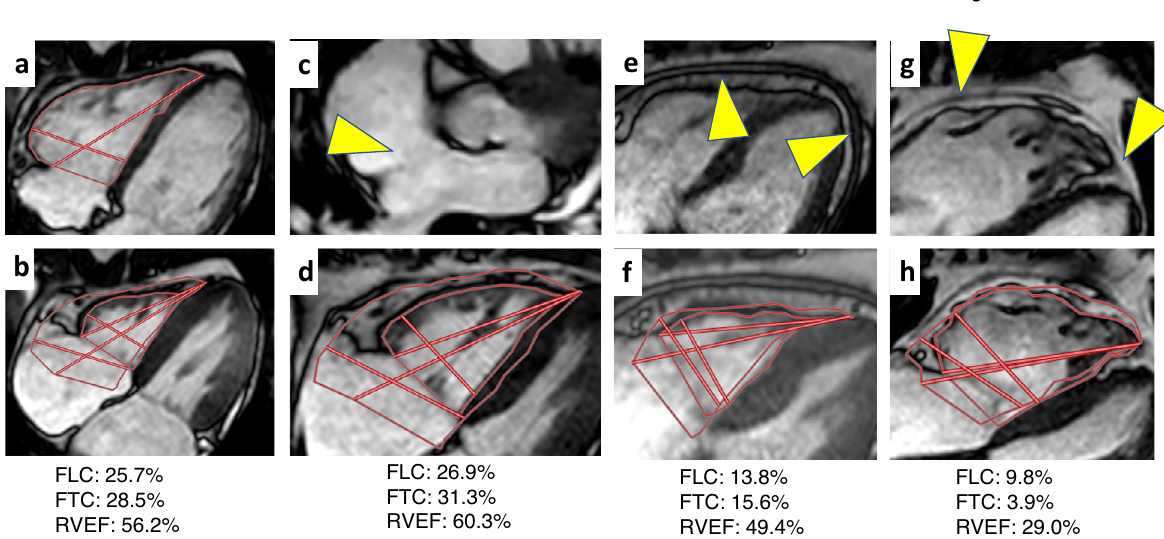
Figure 5. Representative cases. The straight red lines indicate the measured locations for RVLd, RVLs, RVDd, and RVDs. The polygonal lines indicate the endocardium of the RV at end-diastole and end-systole. ( a , b ) Four- chamber cine CMR of a woman in her 40 s; ( a ) end-diastole; ( b ) end-systole. CMR revealed no morphological abnormalities in the RV. ( c , d ) A woman in her 40 s with a history of ventricular tachycardia. CMR revealed an atrial septal defect and a left-to-right shunt ( c , arrow). The Qp/Qs ratio was estimated at 2.2 by the phase- contrast method. ( e , f ) A man in his 70 s with right heart failure. Thickened pericardium is visible ( e , arrow). ( g , h ) A man in his 40 s with a history of ventricular tachycardia. Remarkable impairment of RV contraction, and bulging and fat infiltration of the RV ( g , arrow) are visible. RVLd Right ventricular length at end-diastole, RVLs Right ventricular length at end-systole, RVDd Right ventricular diameter at end-diastole, RVDs Right ventricular diameter at end-systole, CMR Cardiac magnetic resonance imaging.